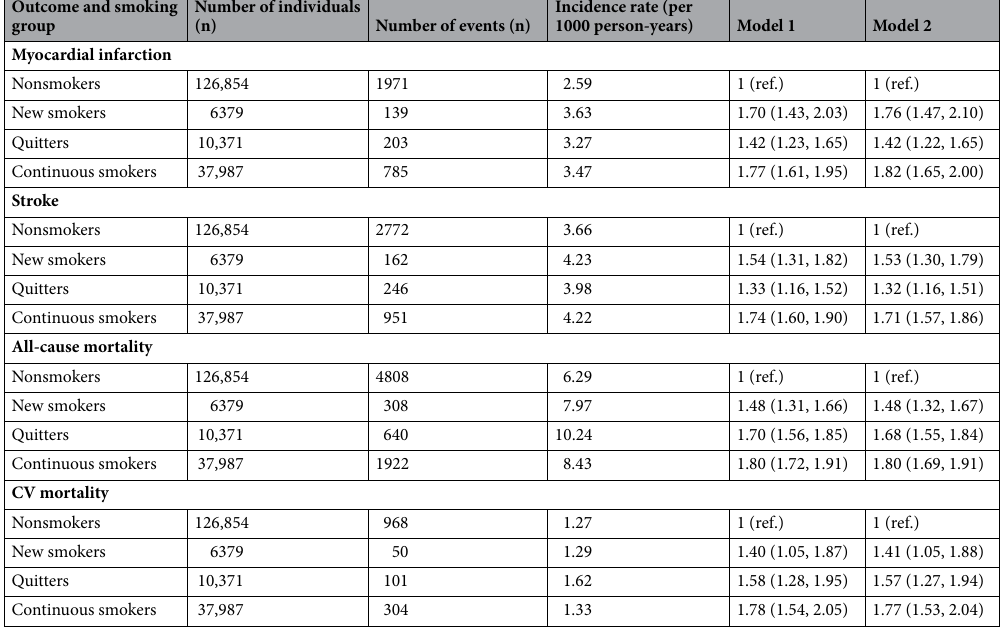
Table 3. Hazard ratios with 95% confidence intervals for myocardial infarction, stroke, and all-cause or cardiovascular (CV) mortality according to the change in smoking status. Model 1; adjusted for age, sex, body mass index, income status, hypertension, dyslipidemia, fasting blood glucose, kidney function, use of insulin, and number of oral hypoglycemic agents. Model 2; model 1 + adjusted for alcohol intake and exercise